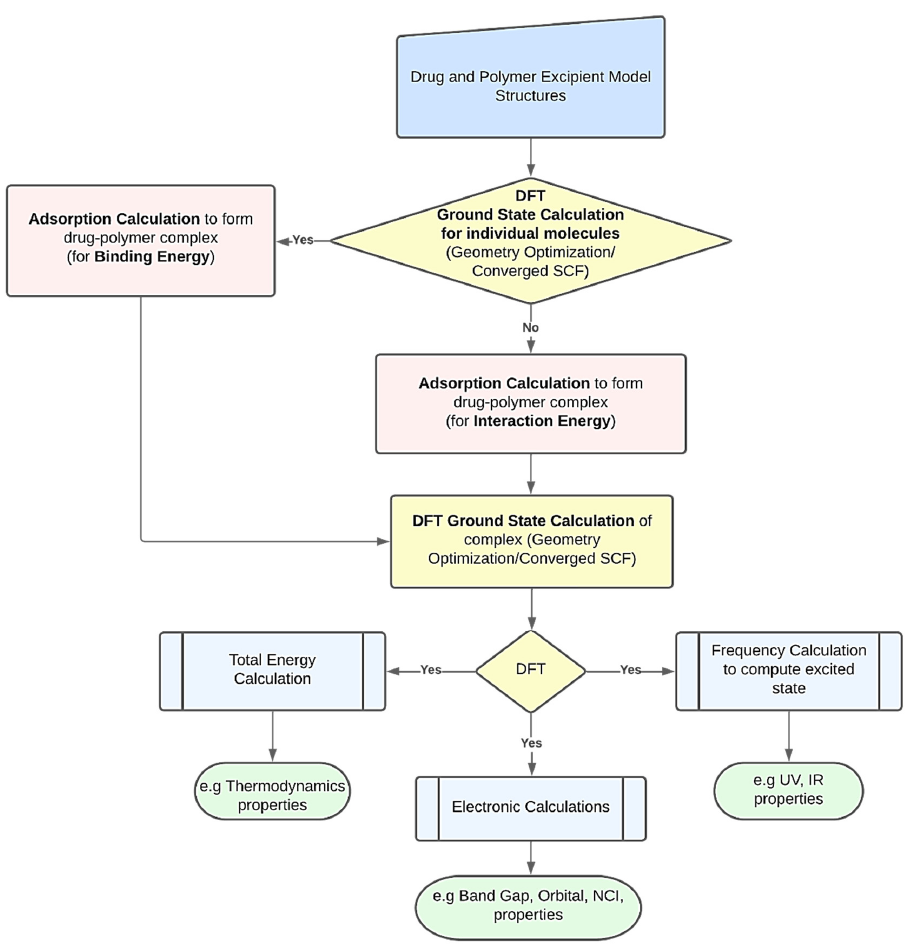
Figure 1. A schematic workflow for employing DFT calculations in polymer-based drug delivery systems.